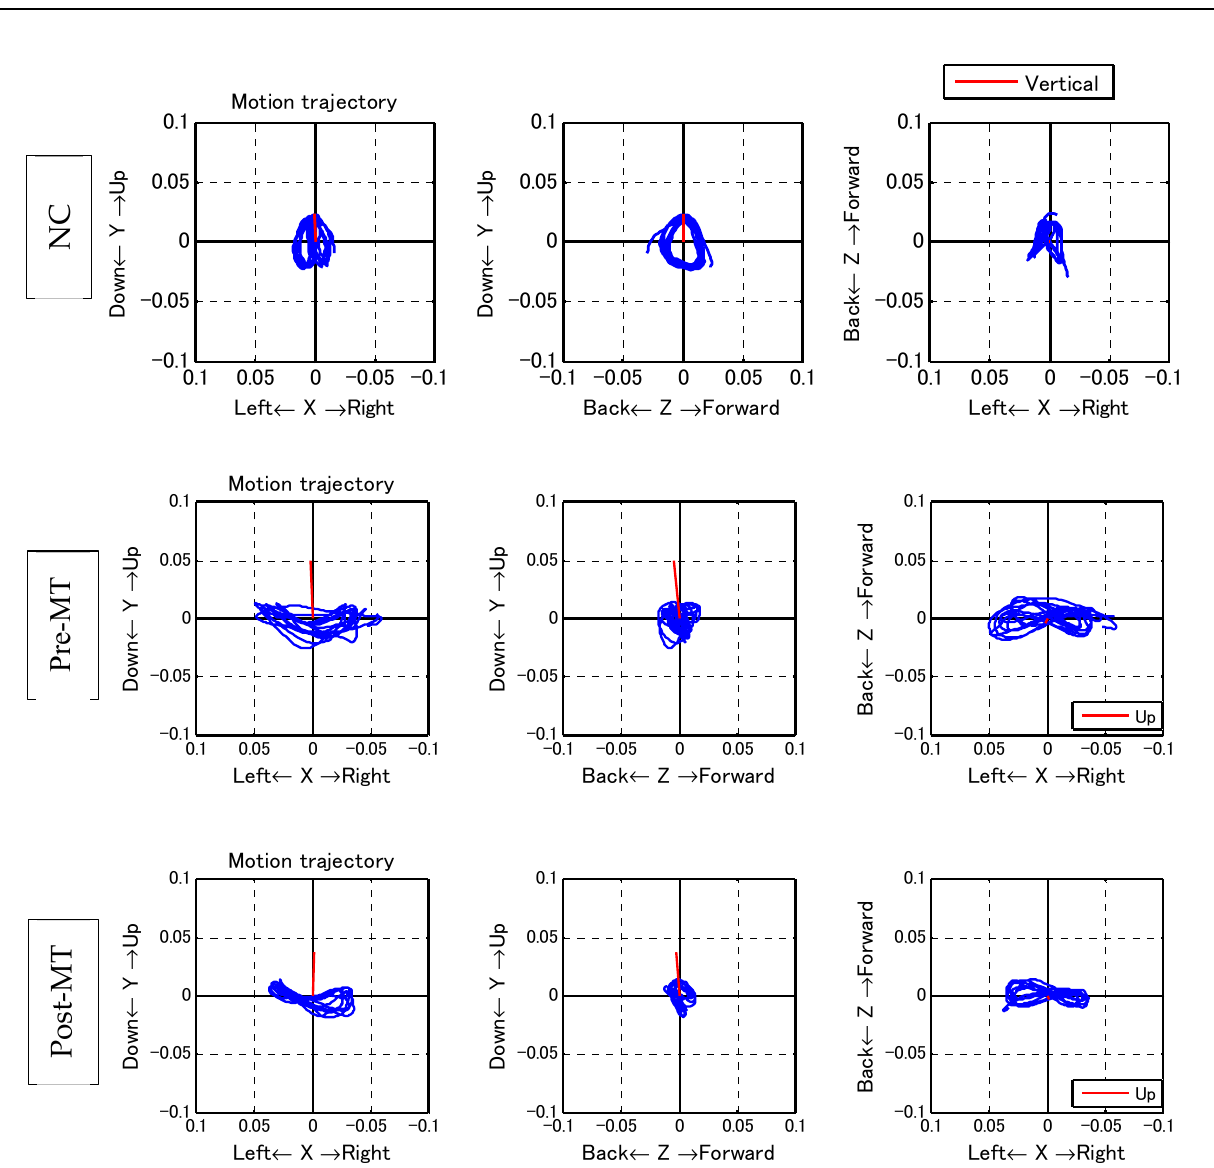
Figure 5. Walking trajectory. With regard to the trajectory of the center of the body, mediolateral (ML) amplitude, which is typically large for individuals with Parkinson’s diseases, decreased significantly. Left row: coronal plane; middle row: sagittal plane; right row: horizontal plane. Upper row: the walking trajectory of a healthy 70-year-old woman. The trajectory was symmetrical and forms a butterfly pattern in the coronal and horizontal plane. On the sagittal plane, the trajectory forms a symmetrical circle. Middle row: Pre-MT walking trajectory of one subject. Lower row: Post-MT walking trajectory of the subject shown in the middle row.